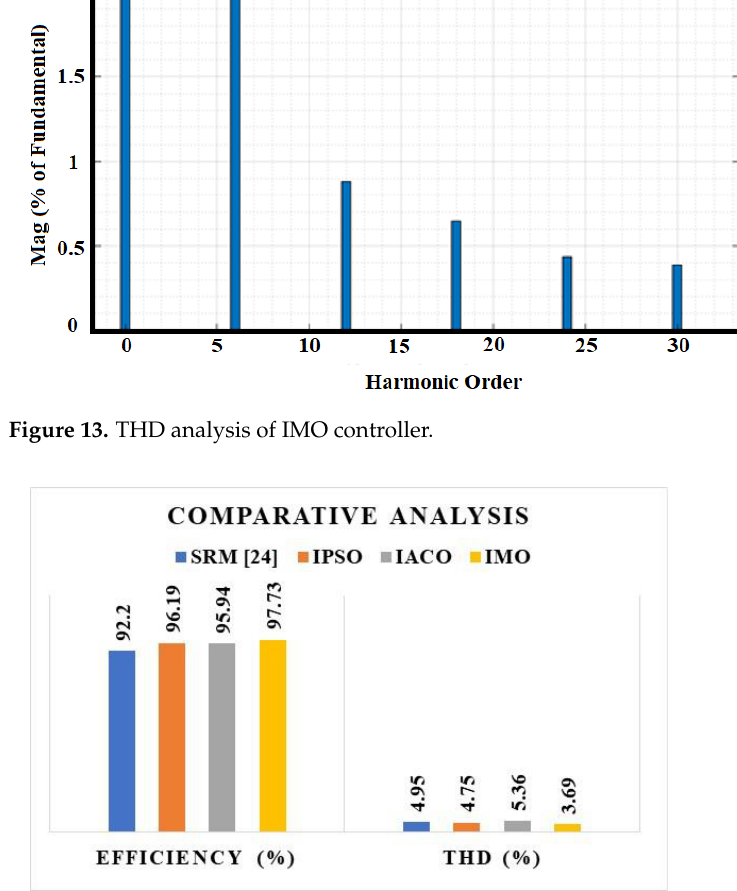
Figure 14. Comparative